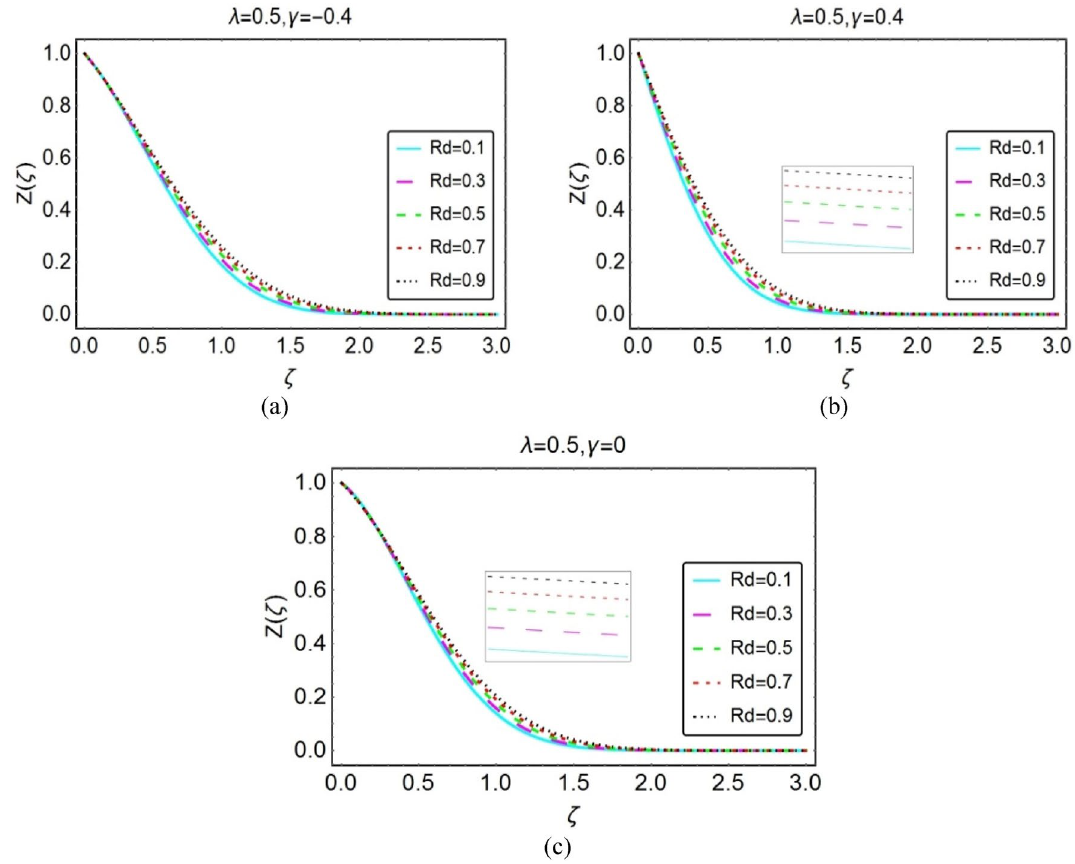
Figure 7. Impacts of Rd on Z (ζ) for ( a ) opposing ( b ) assisting and ( c ) static case.